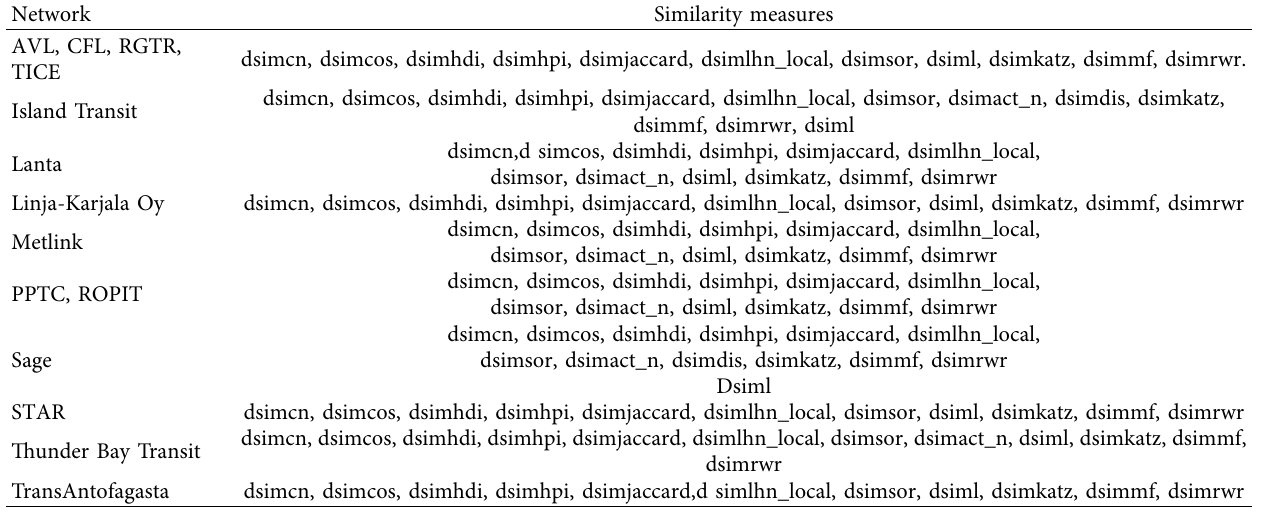
Table 3: Similarity measures that present a Spearman correlation higher than 0.9 with another. Network